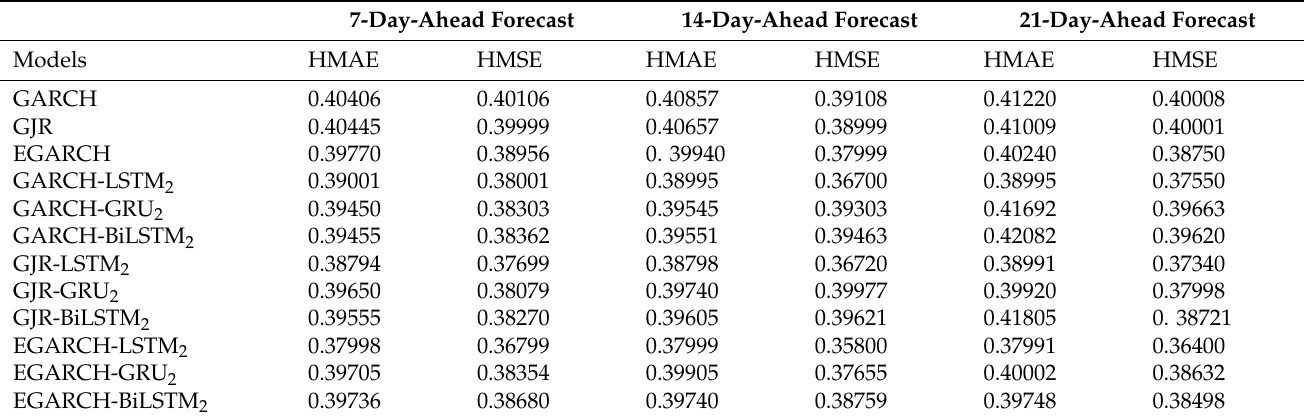
Table 3. Out-of-sample forecast results for GARCH-type and hybrid models. 7-Day-Ahead